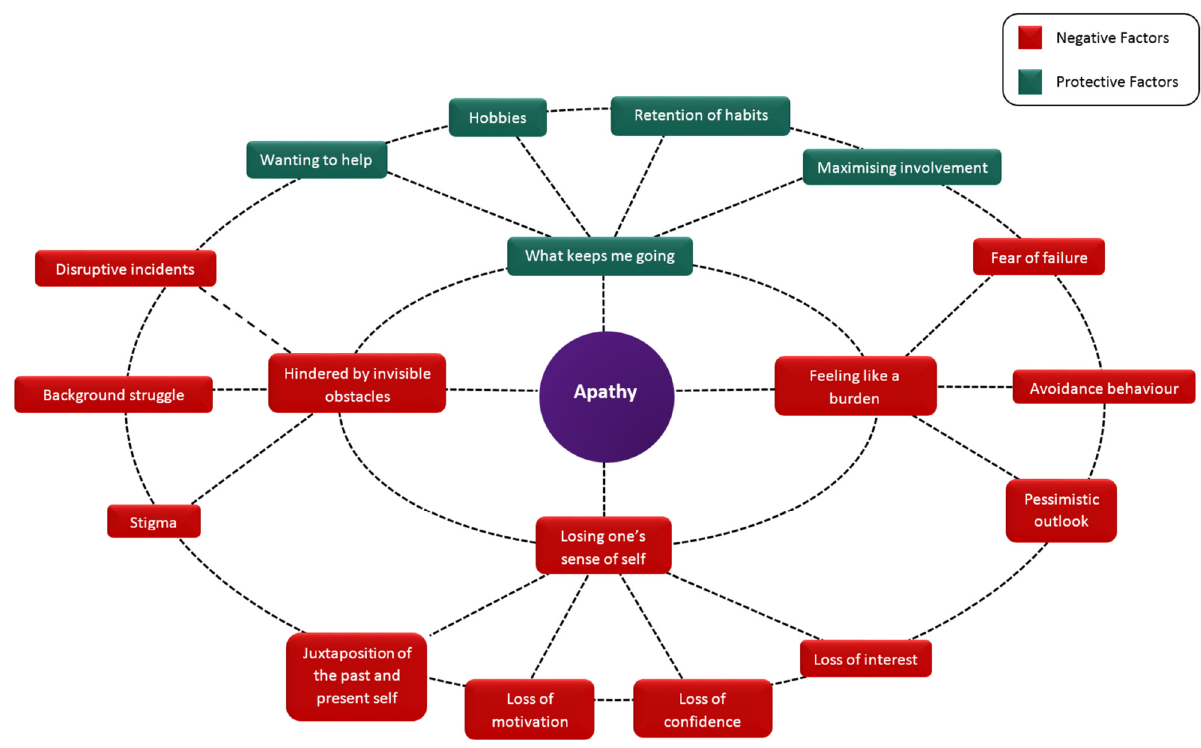
Figure 1. The subjective experience of apathy in dementia, with superordinate themes (inner ring) and subthemes (outer ring). Table 2. Superordinate themes, subthemes, and illustrative quotes.